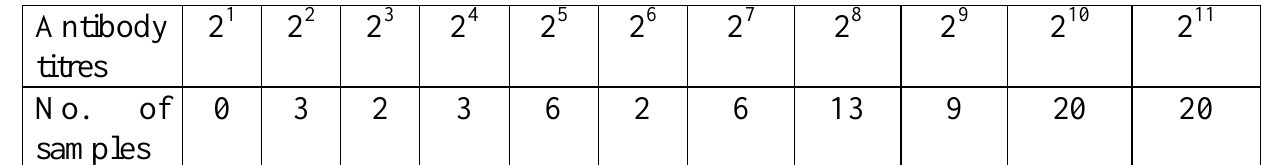
no or few worms